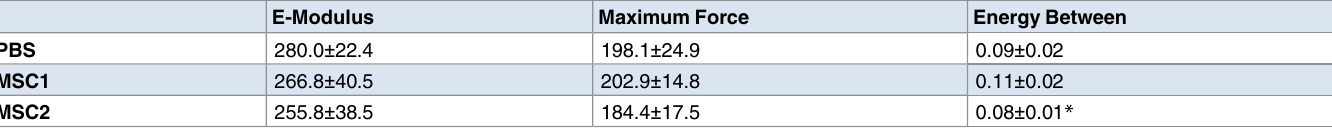
Table 1. Four-point bending mechanical test of the fractured femur (n =